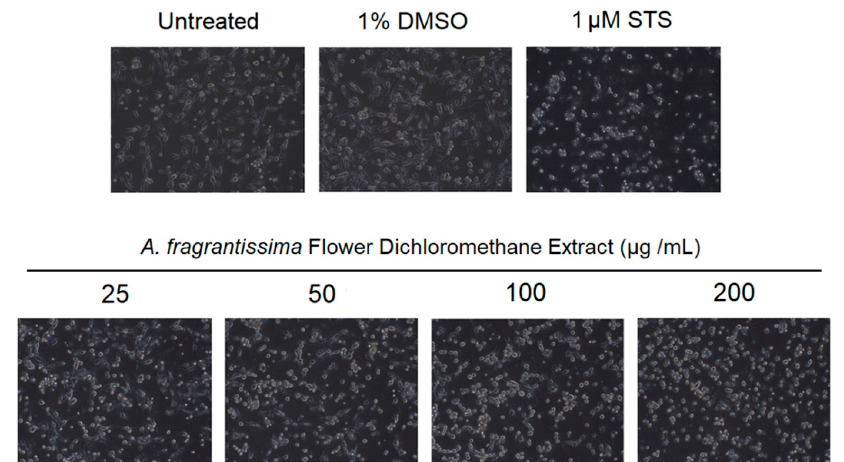
Figure 3. Microscopic images of the MDA-MB-231 cells treated with increasing concentrations of A. fragrantissima flower dichloromethane extract displaying apoptosis-related morphological changes in cell shrinkage. The MDA-MB-231 cells display a dose-dependent increase in cell shrinkage, a morphological characterization related to apoptosis. The cell shrinkage that occurred in the MDA-MB-231 cells treated with 200 µg/mL of A. fragrantissima flower dichloromethane extract was similar to the cells treated with the strong apoptosis inducer STS, the positive control.